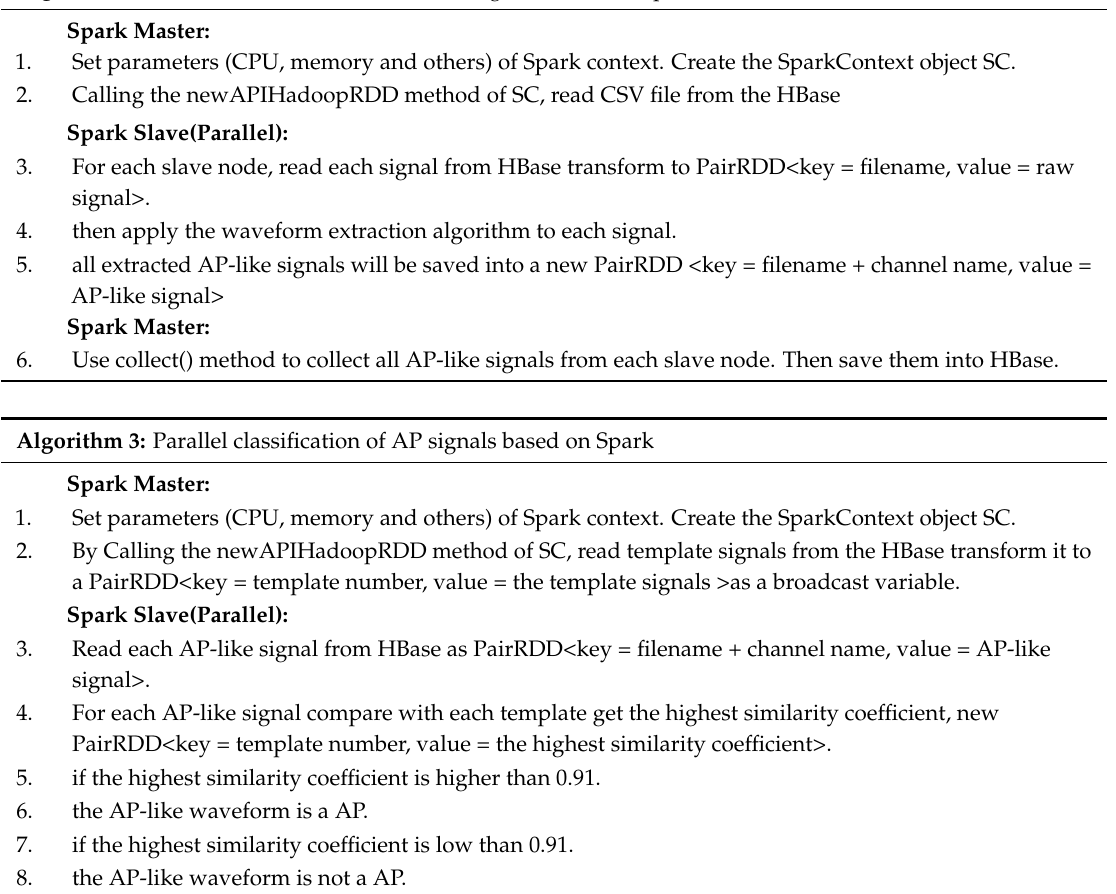
Algorithm 2: Parallel extraction of all AP-like signals based on Spark